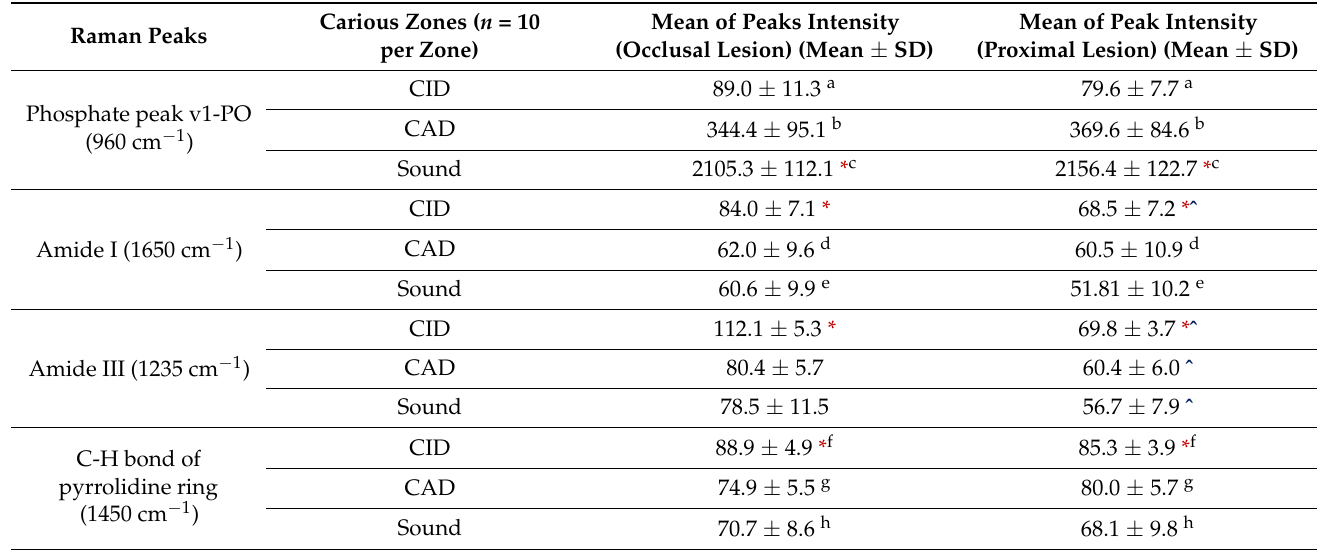
Table 1. Raman band intensities A.U. (Mean ± SD) of caries-infected, caries-affected and sound dentin in occlusal and proximal carious lesions.